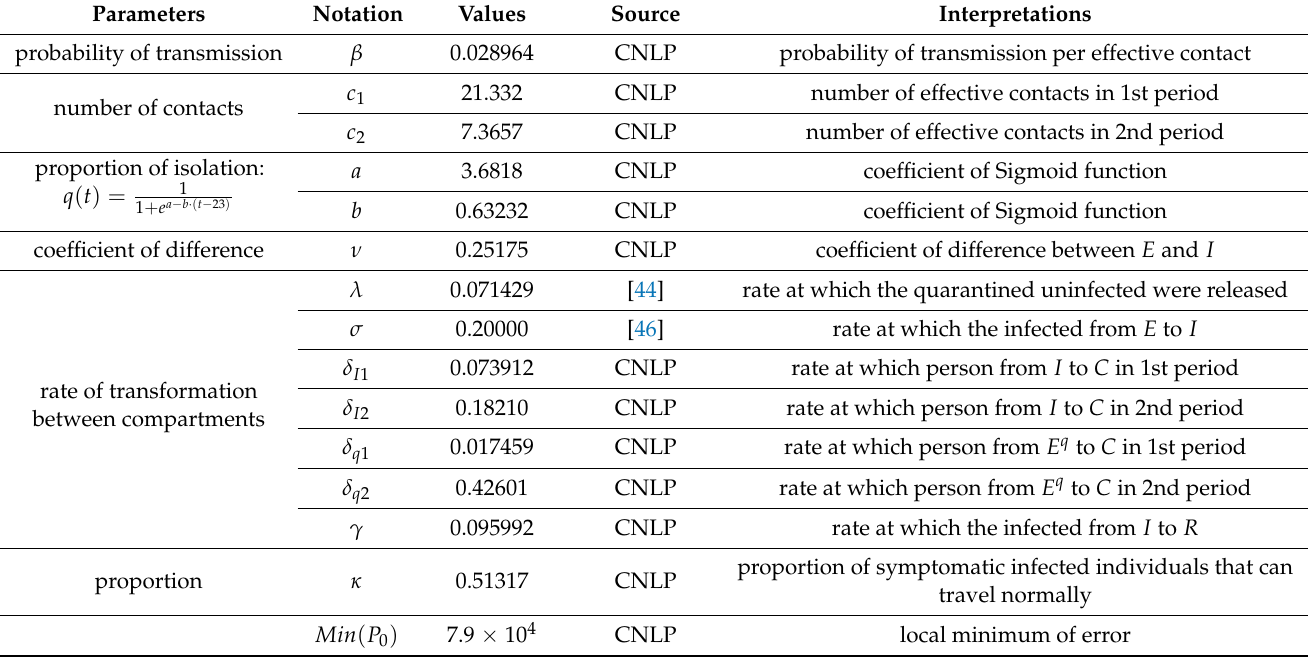
Table A2. Definition of the parameters and possible values obtained by solving optimization